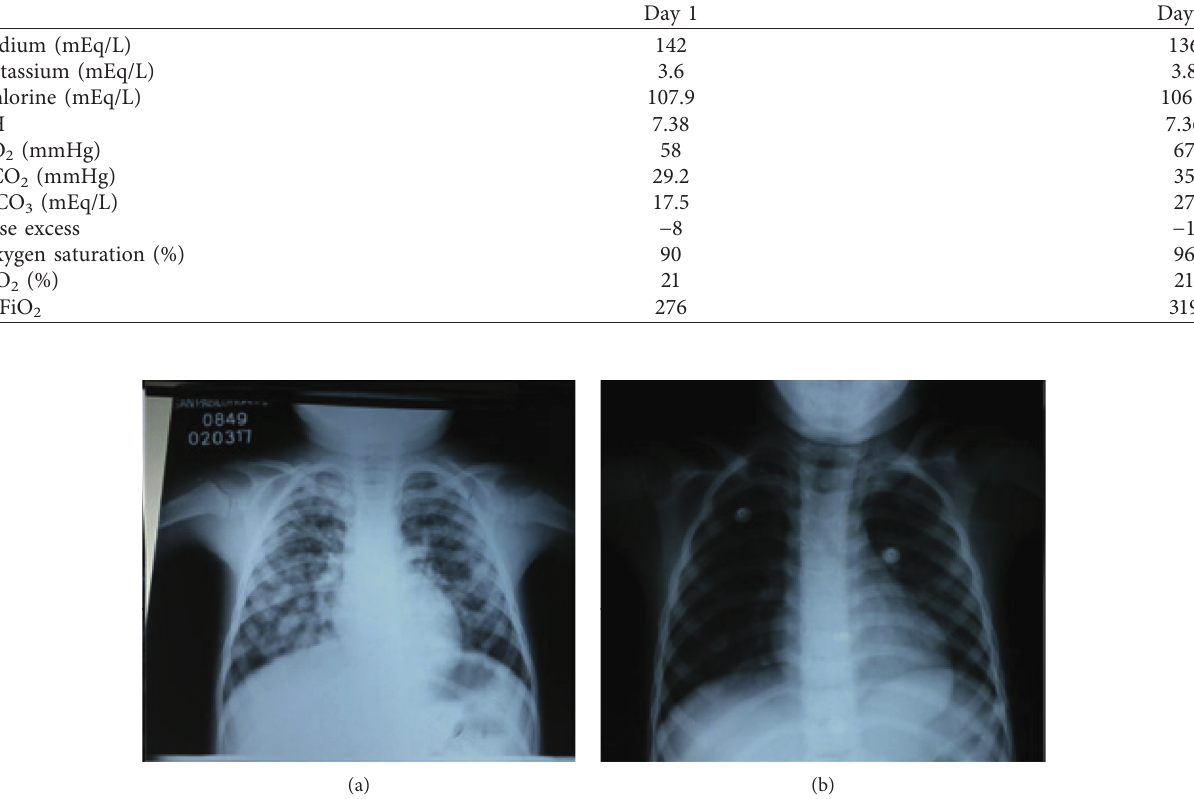
Table 1: Arterial gas and electrolyte analysis.